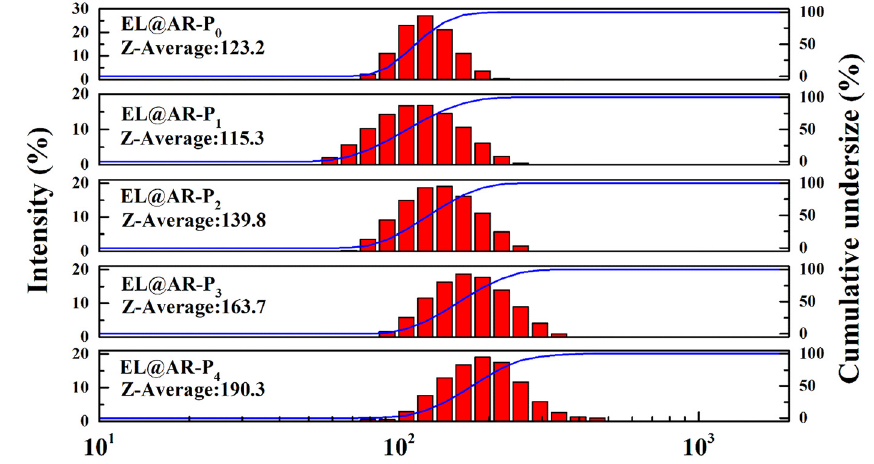
Figure 3: Particle size distribution of EL@AR - P emulsions.